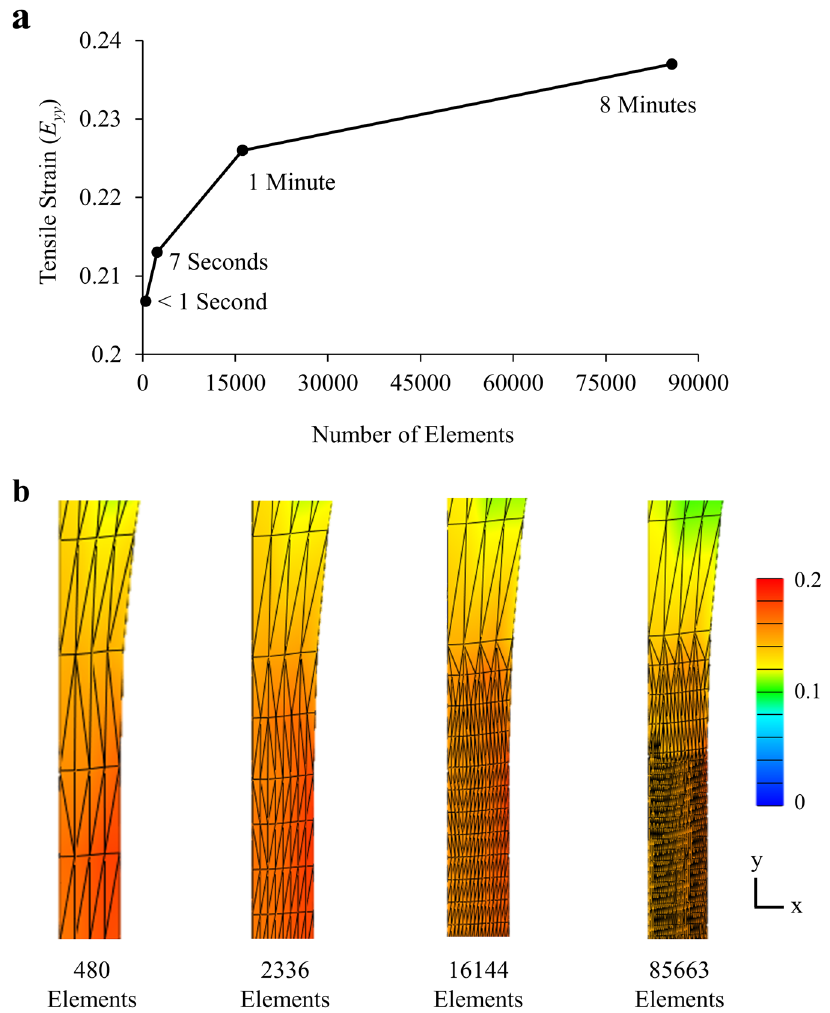
Figure 2. Mesh convergence study. ( a ) Increasing mesh size resulted in longer run times and greater tensile strain ( E yy ) inside the tear region that gradually plateaued. ( b ) Strain maps ( E yy ) of different mesh sizes. This study used 16,144